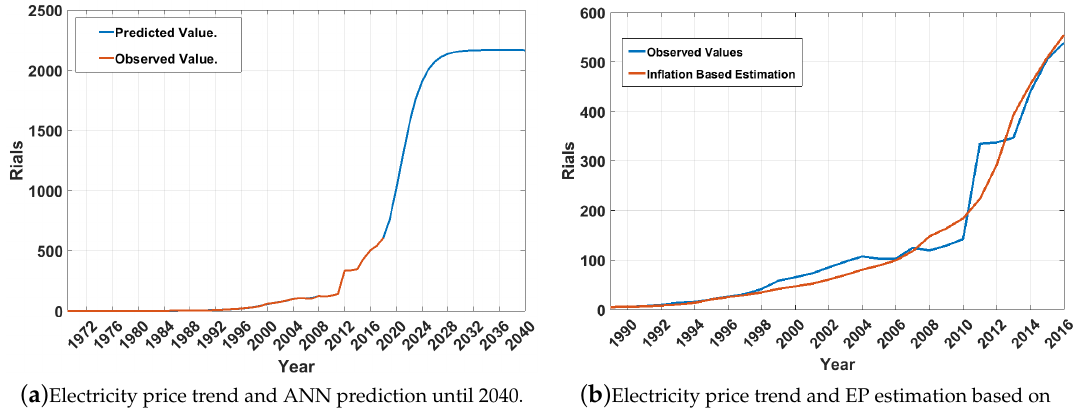
Figure 7. Iranian electricity price prediction and time series.